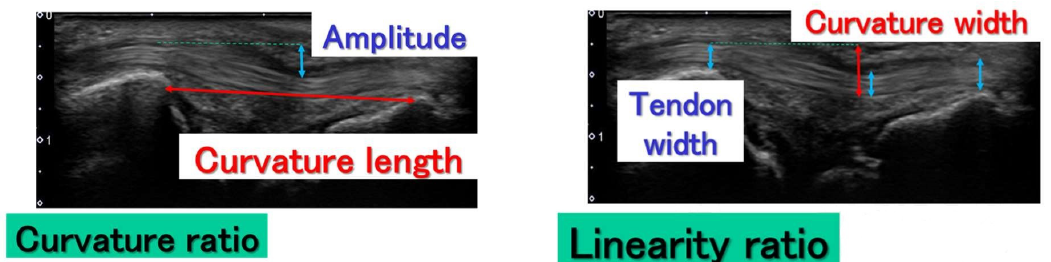
Figure 2. Schemas of how the curvature and linearity ratios were calculated. The curvature ratio was defined as the amplitude divided by the curvature length. The linearity ratio was defined as the curvature width divided by tendon width. The amplitude was defined as the vertical distance of the dorsal border of the extensor carpi ulnaris tendon between the level of the ulnar styloid process and location of the tendon on the deepest side. Curvature length was the distance between the ulnar styloid process and triquetrum.